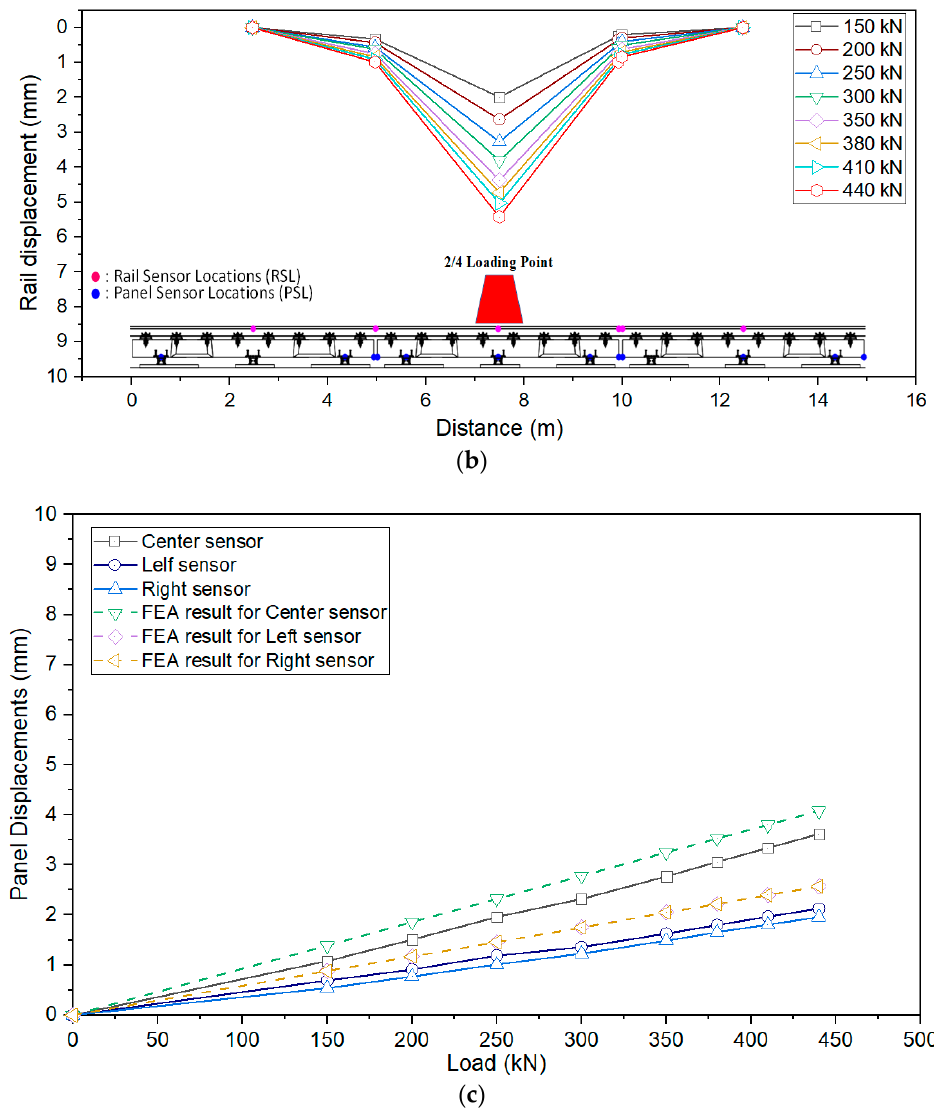
Figure 10. Three-panel vertical displacement test results (Load case I) ( a ) vertical displacement of the panel (mm), ( b ) rail vertical displacement (mm), and ( c ) comparison between FEA and test results (mm).